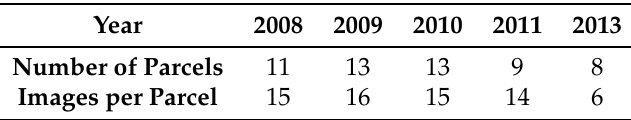
Figure 4. Study area located in Sevilla, SW Spain. Coordinates are in Universal Transverse Mercator World Geodetic System 84 (UTM WGS)-84. Table 2. Set of parcels with auxiliary phenological information